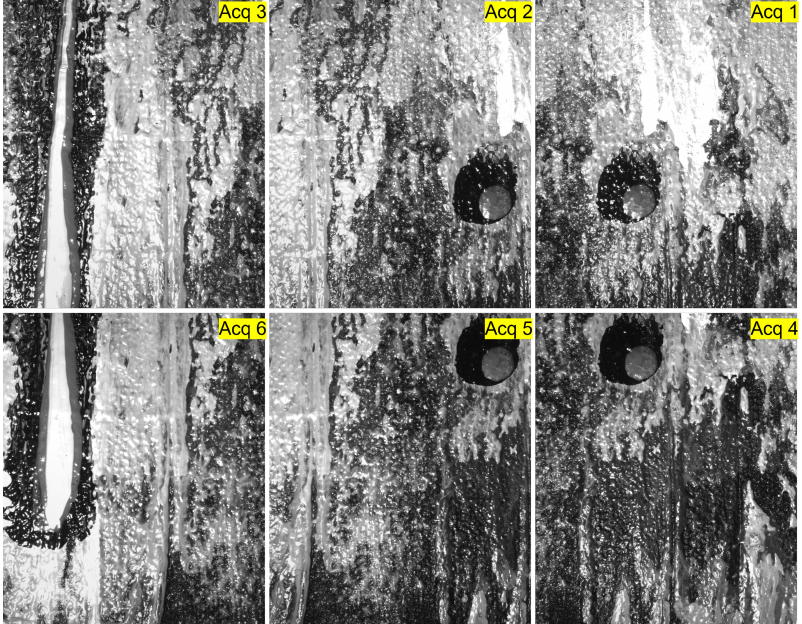
Figure 8. RTI acquisitions of a canvas painting (24.5 cm × 20 cm) in parts. There are in total 6 acquisitions, each covering an area of 9.3 cm × 7.6 cm with 30 % overlap between each pair of consecutive acquisitions.